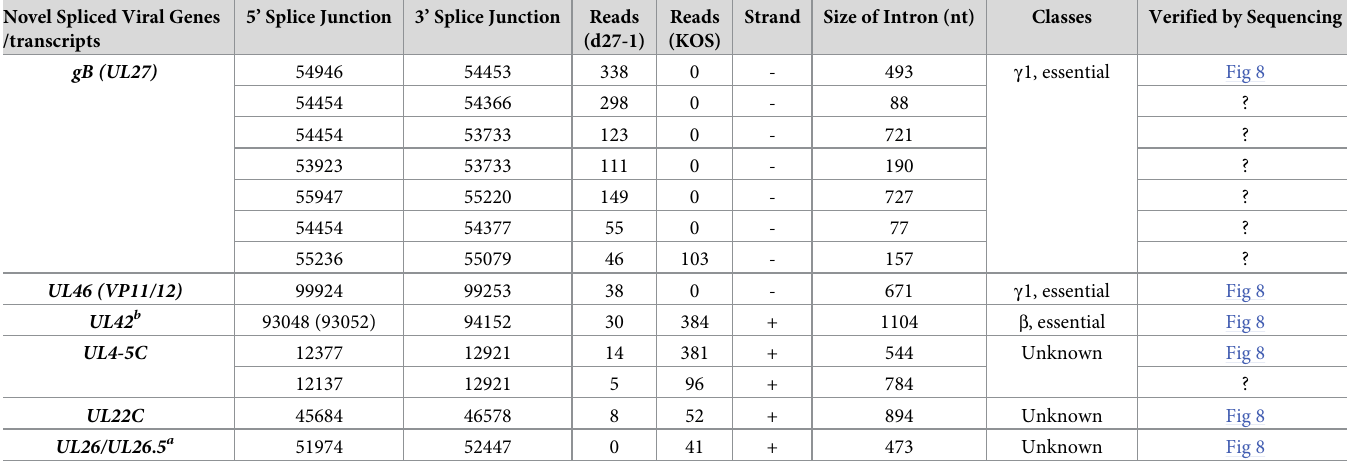
known to be a spliced gene. Splices from a 5’ splice junction (nt125650) in the coding region of ICP34 . 5 to 3’ splice junctions (predominantly) at nt124046 in the 5’ UTR region of ICP0 and (less frequently) at nt123186, which is also the acceptor splice site of ICP0 intron 1 were identi- fied (Table 2 and Fig 5A). The predominant spliced ICP34 . 5 transcript isoform (125650^124046) was readily detectable in d27-1 infected cells by RT-PCR but was barely detectable in KOS infected cells (Fig 5B). Two minor splice junctions (124467^124046 and 124467^123186) were also confirmed by RT-PCR (Fig 5B). Expression of HSV-1 ICP34.5 pro- tein was abolished in d27-1 infected cells (Fig 5C). Further analysis of the splicing efficiency of these novel splice sites in the ICP34.5 region indicates that splicing of the ICP34.5 pre-mRNA is only efficient when ICP27 is absent (Fig 5D). When ICP27 is absent, 12560^124046 is the major splice with approximately 62% intron removal efficiency, followed by 123402^123186, 12560^123186 and 12560^124047. Splicing of 124467^124046 and 124467^123186 is very inefficient (below 0.5%) in the presence of ICP27 or not. Splicing of these novel introns is more efficient when ICP27 is absent. As discussed in Fig 3, splicing of ICP0 intron 1 and intron 2 is efficient with slight intron retention in ICP0 intron 1 in KOS infected cells. To be more rig- orous, we also performed quantitative analysis of the novel alternative 5’ss (nt123402) of ICP0 intron 1. Splicing of this alternative ICP0 intron 1 appears to be enabled in the presence of ICP27, similar to the case with the alternative 3’ss (nt 122380 and 122377) of ICP0 intron 2 (Fig 4D). We next performed Northern blot of viral RNAs containing ICP34 . 5 exon 1 in HEK- 293 cells infected with wild-type HSV-1 or ICP27 mutants using a probe corresponding to